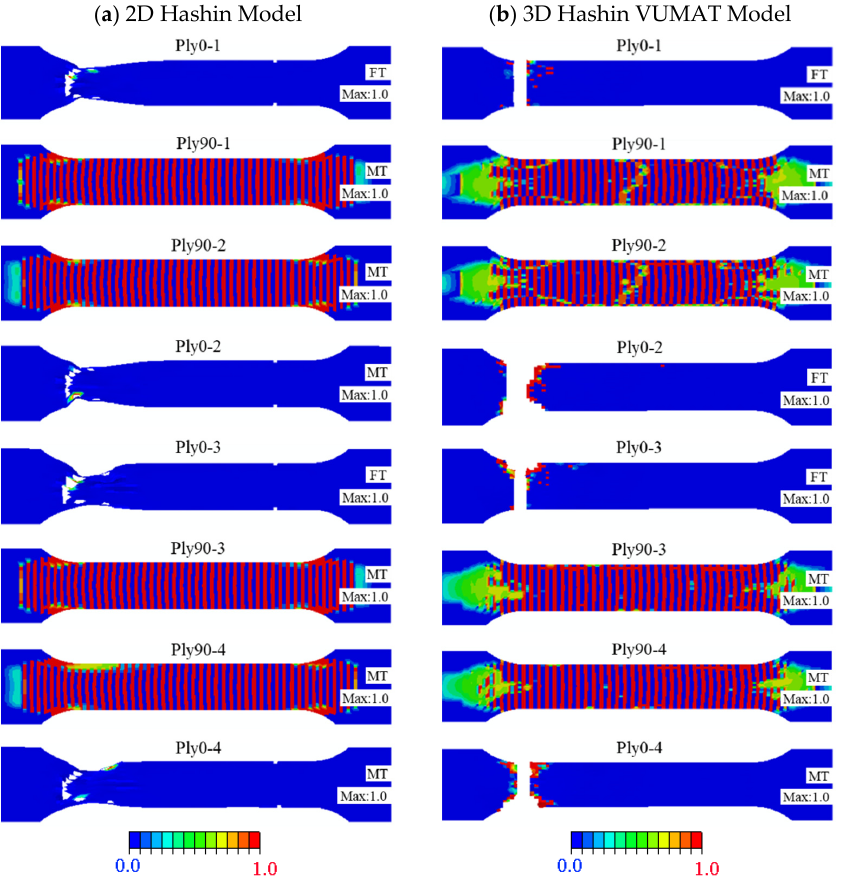
Figure 14. The final damage patterns of carbon fibre layers: ( a ) 2D Hashin model ( b ) 3D Hashin model.